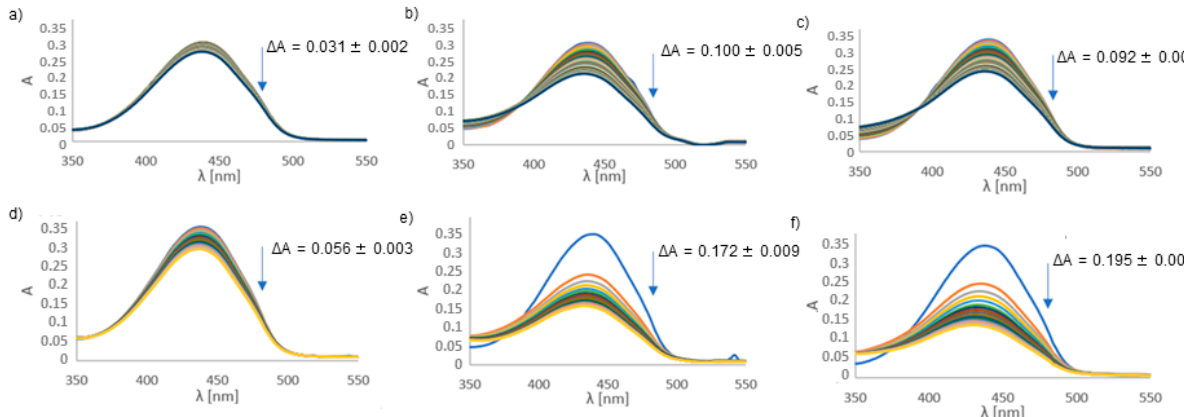
Figure 5. UV-Vis spectra of NDMA in the presence of hydrogen peroxide: measured for one hour every 1 min with ( a ) copper (II) ions (control), ( b ) Cu(II)-L 1 complex and ( c ) Cu(II)-L 2 complex; measured every hour for 15 h with ( d ) copper (II) ions (control), ( e ) Cu(II)-L 1 complex and ( f ) Cu(II)-L 2 complex.